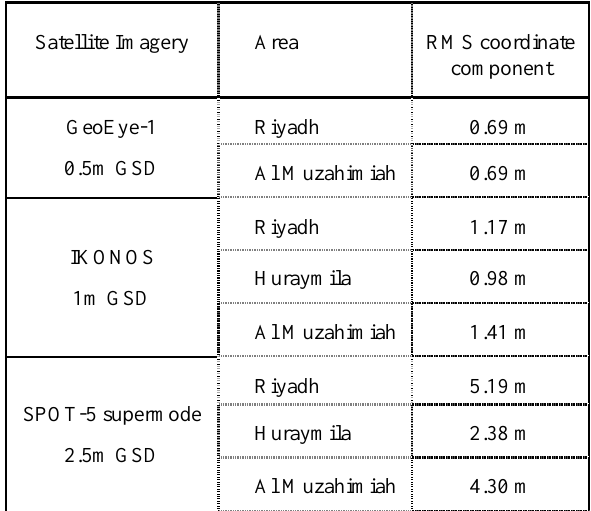
Table 4. Root mean square differences of coordinates of mapped features